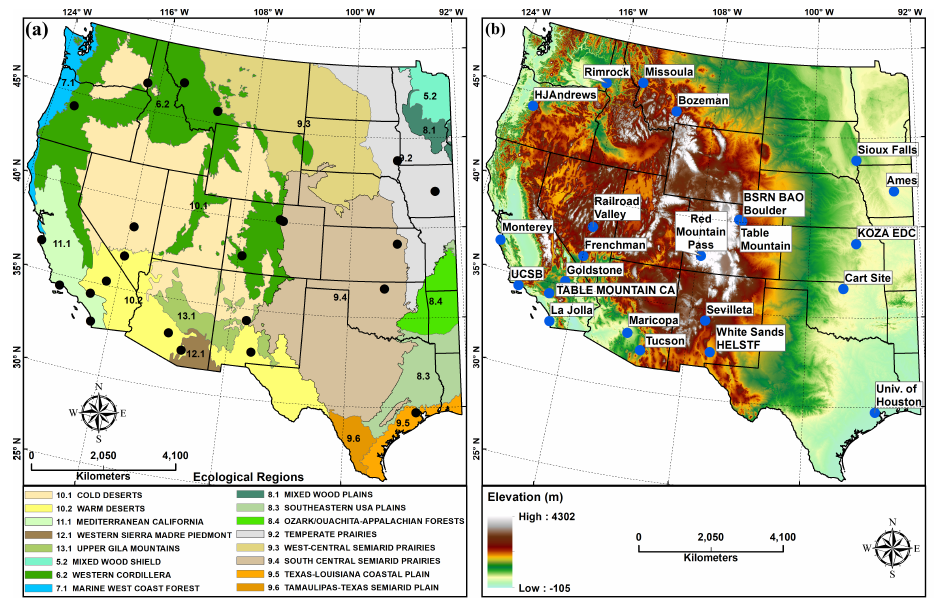
Figure 1. ( a ) Ecological regions of the western United States acquired from the Commission for Envi- ronmental Cooperation (US Environmental Protection Agency). Black dots represent the AERONET stations. ( b ) Digital Elevation Model (DEM) map of the western United States extracted from global GTOPO30 model at 30 arc seconds ( ≈ 1 km) spatial resolution (USGS). Black and blue dots represent the AERONET